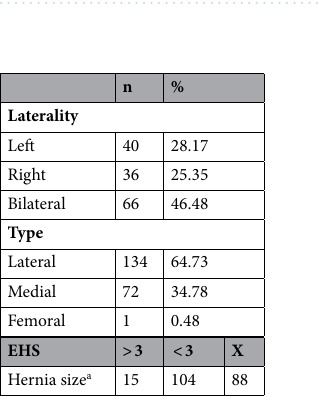
Table 1. Patients demographics. a There is no significant difference between sex.